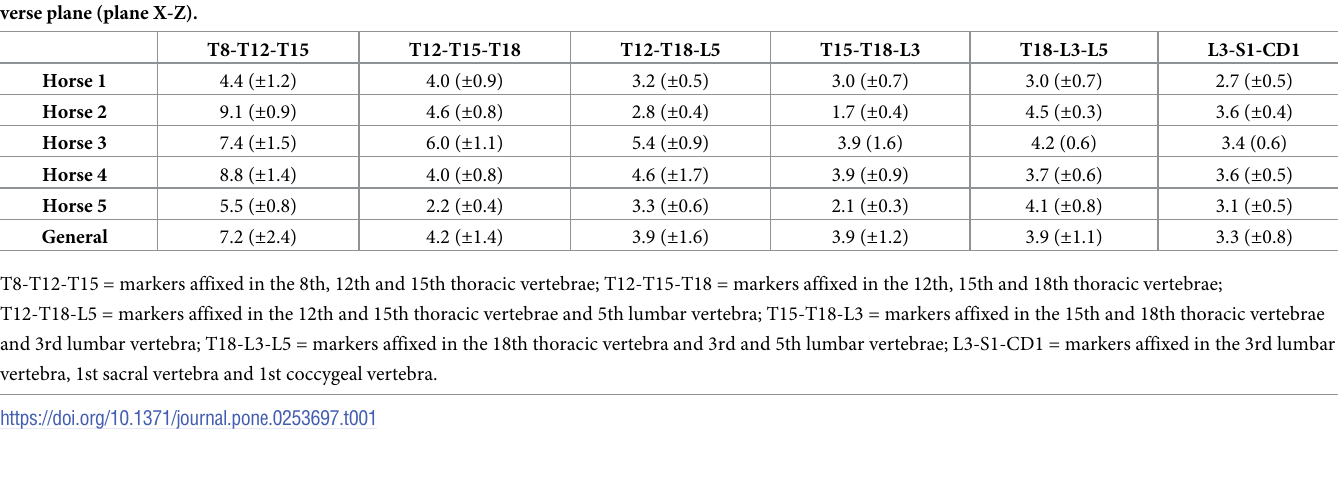
Table 1. Mean ( ± standard deviation) range of motion (ROM) in degrees ( ⁰ ) of individual horses and all horses (General) at different angles analyzed in the trans- verse plane (plane X-Z). T8-T12-T15